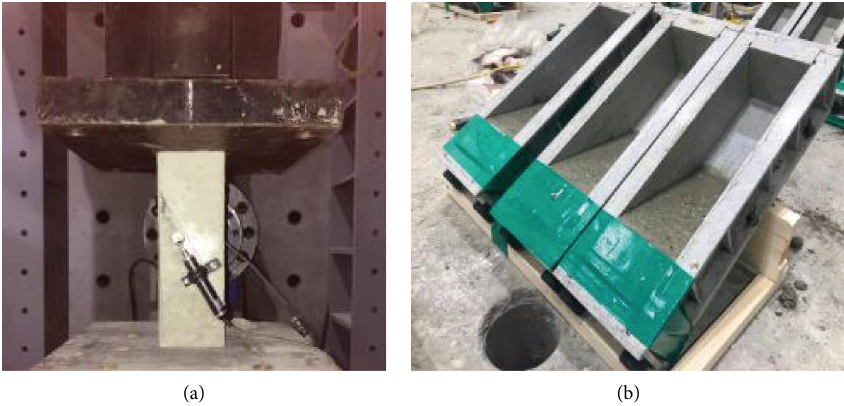
Figure 1: Test and formworks set-up. (a) Test setup. (b) Formwork setup.